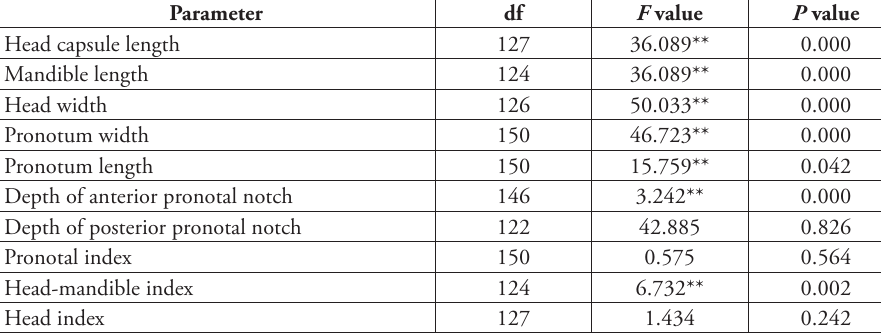
Table 1. Results of an ANOVA assessing variation of select morphometric parameters. Parameters exhib- ited statistically significant differentiation if P <0.05.